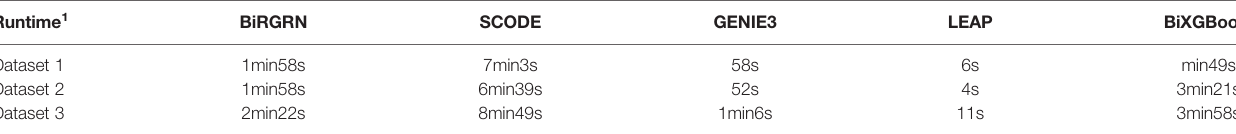
TABLE 3 | The runtime of each method for three real datasets.